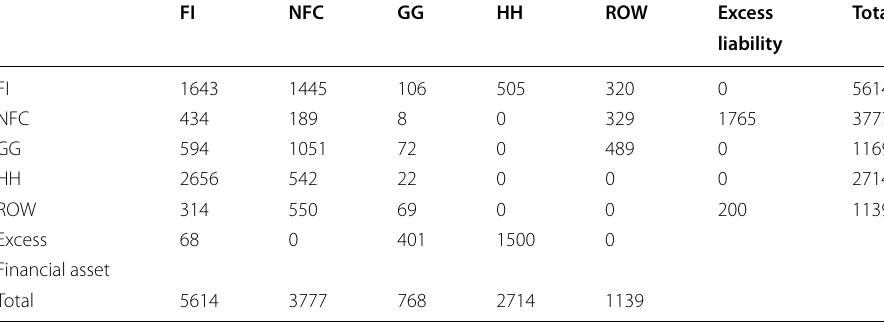
Source: created by authors using OECD.Stat data Table 3 FFS Table for the U.S. (in units of 1 billion USD) FI